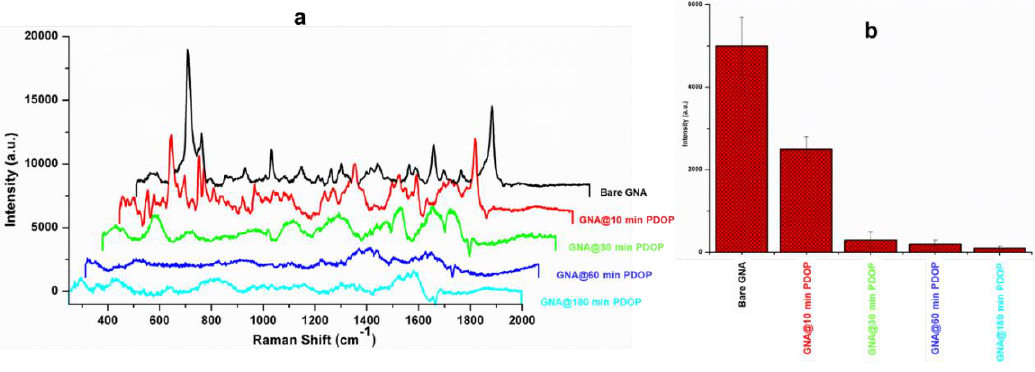
Figure 2. UV–vis absorption spectra ( a ) and TEM image ( b ) of AgNPs.